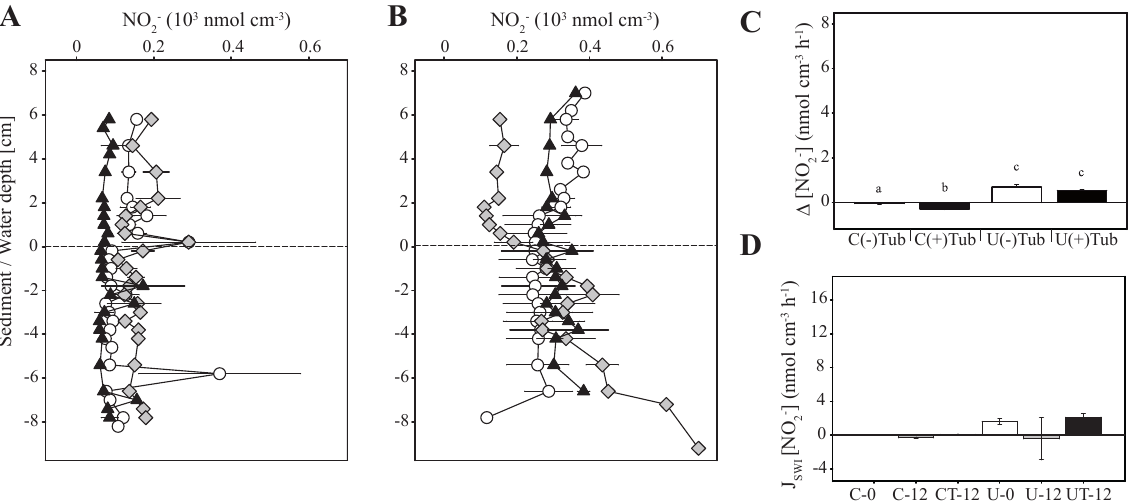
Figure 6. Dissolved nitrite concentration profiles in uncontaminated ( A ) and U-spiked sediment ( B ) in the different treatments: at initial conditions [C-0] and [U-0] ( (cid:13) ), and after 12 days without [U-12] ( ♦ ) or with [UT-12] ( N ) T. tubifex worms in the sediment. The bar chart (C) corresponds to the net outward flux in the water column after 12 days. The bar chart ( D ) indicates the corresponding diffusive fluxes at the sediment–water interface estimated using PROFILE software. Means ± SD ( N = 3). Different letters correspond to significant differences between treatments (no significant differences detected in D